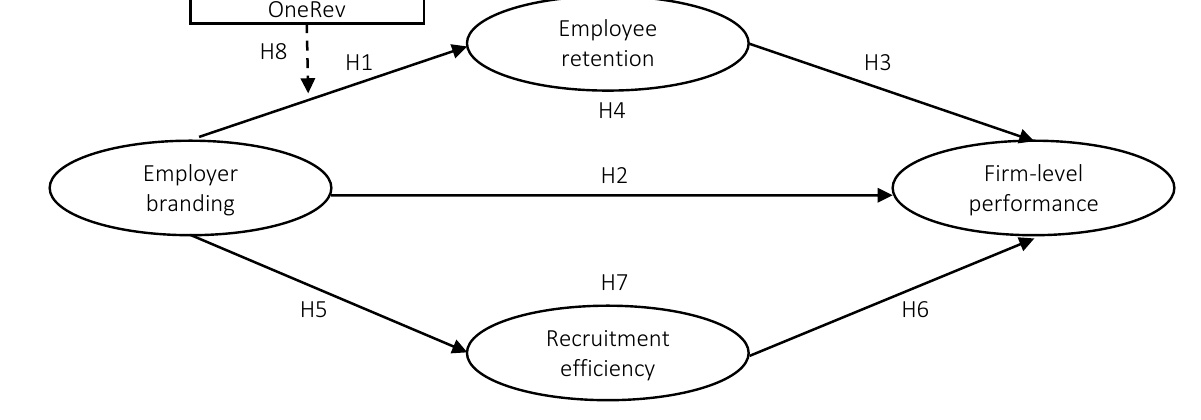
Figure 1. Conceptual